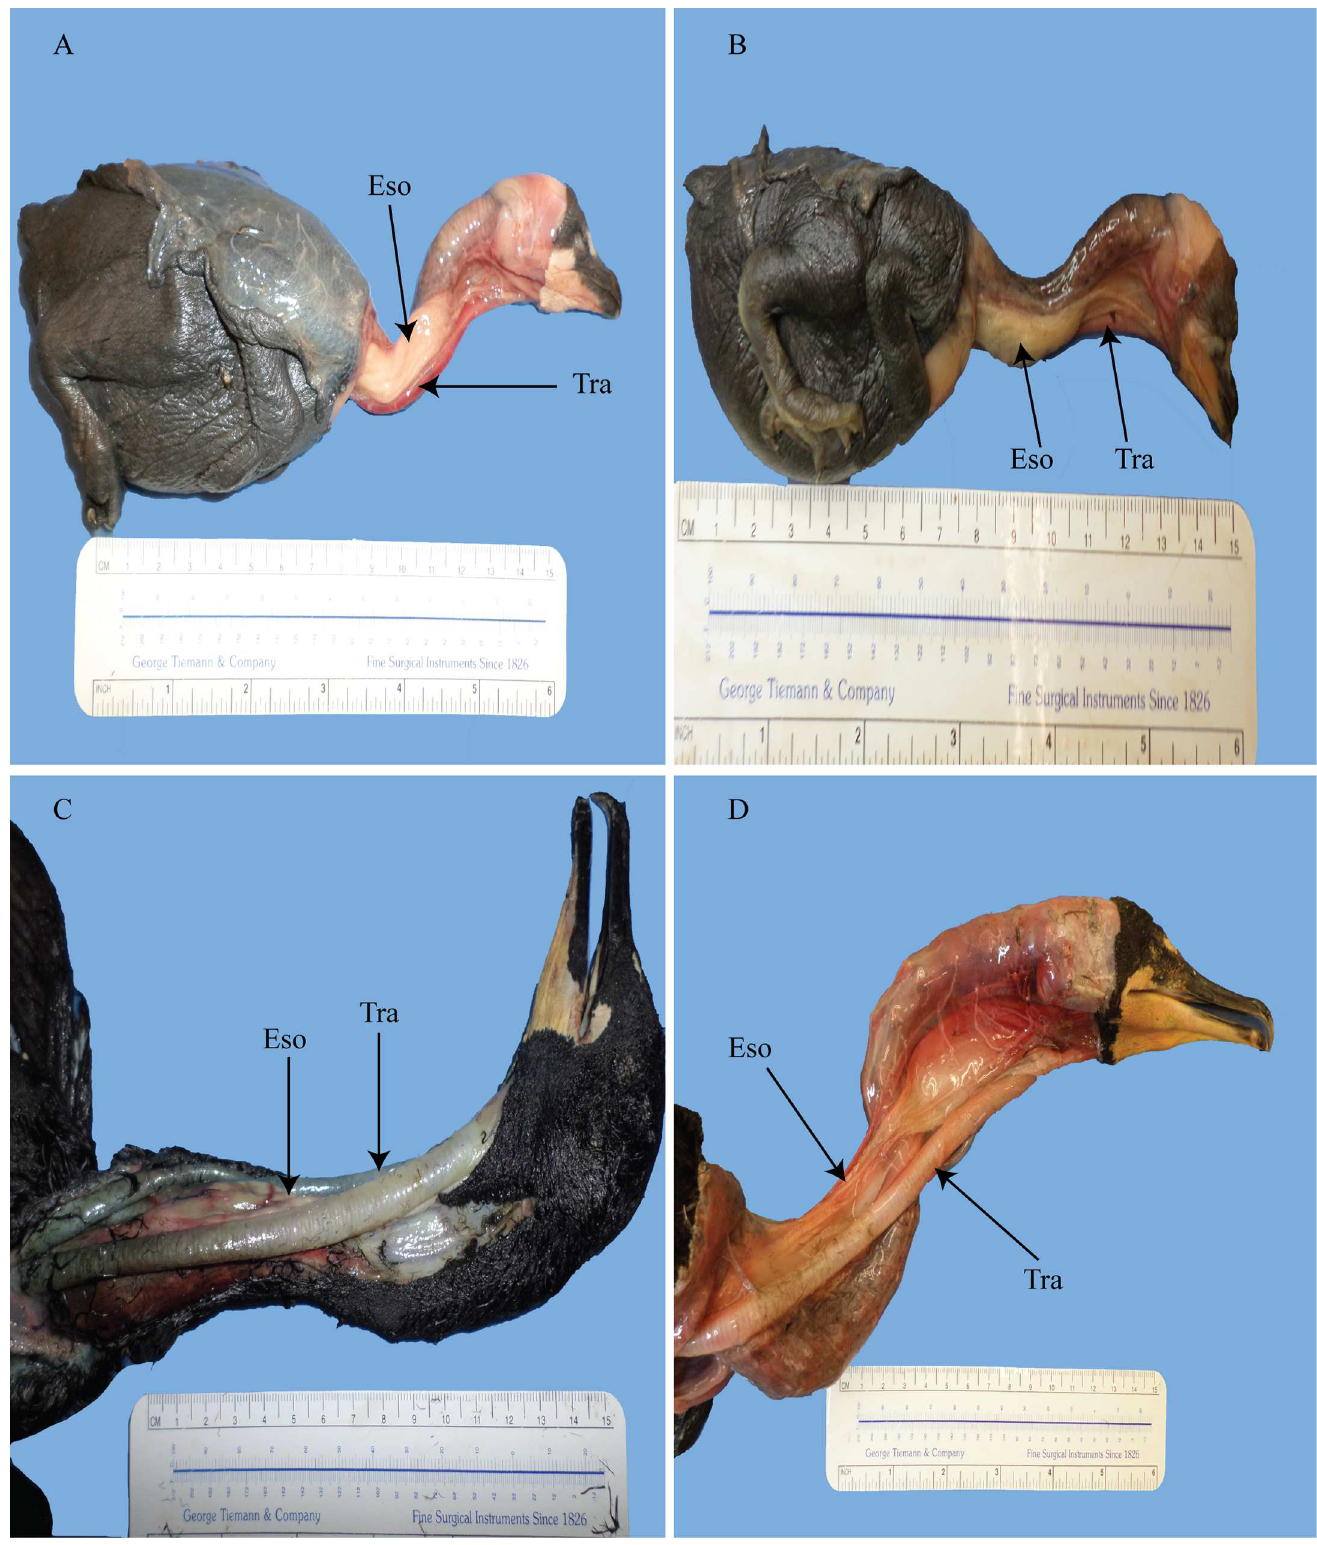
Fig 6. The course of the tracheaand esophagusin P . auritus . (A and B) lateralview of hatchling P . auritus .(C) ventral view of juvenile P . auritus showing a midsagittalplacement of the trachea.(D) lateralview of adult P . auritus .Tra = trachea;Eso = esophagus.